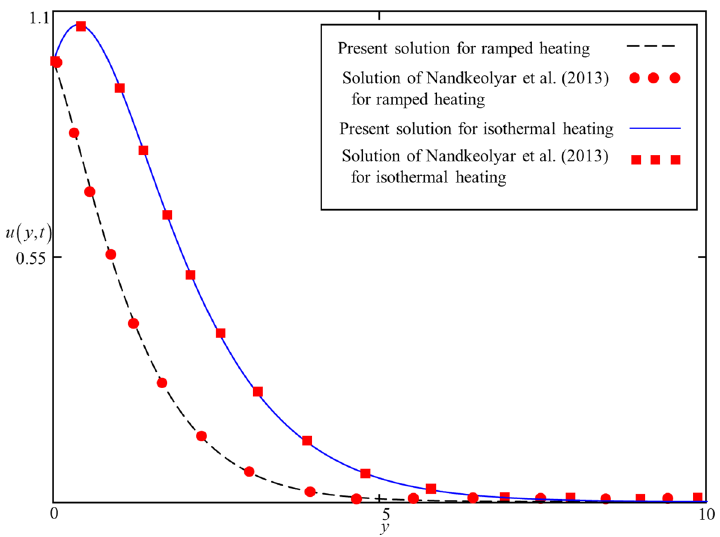
Figure 3. Comparison of present solutions presented in Eqs. (95), (102) and Nandkeolyar et al. 45 , Eq. (20) for t = 0.5, 1.5